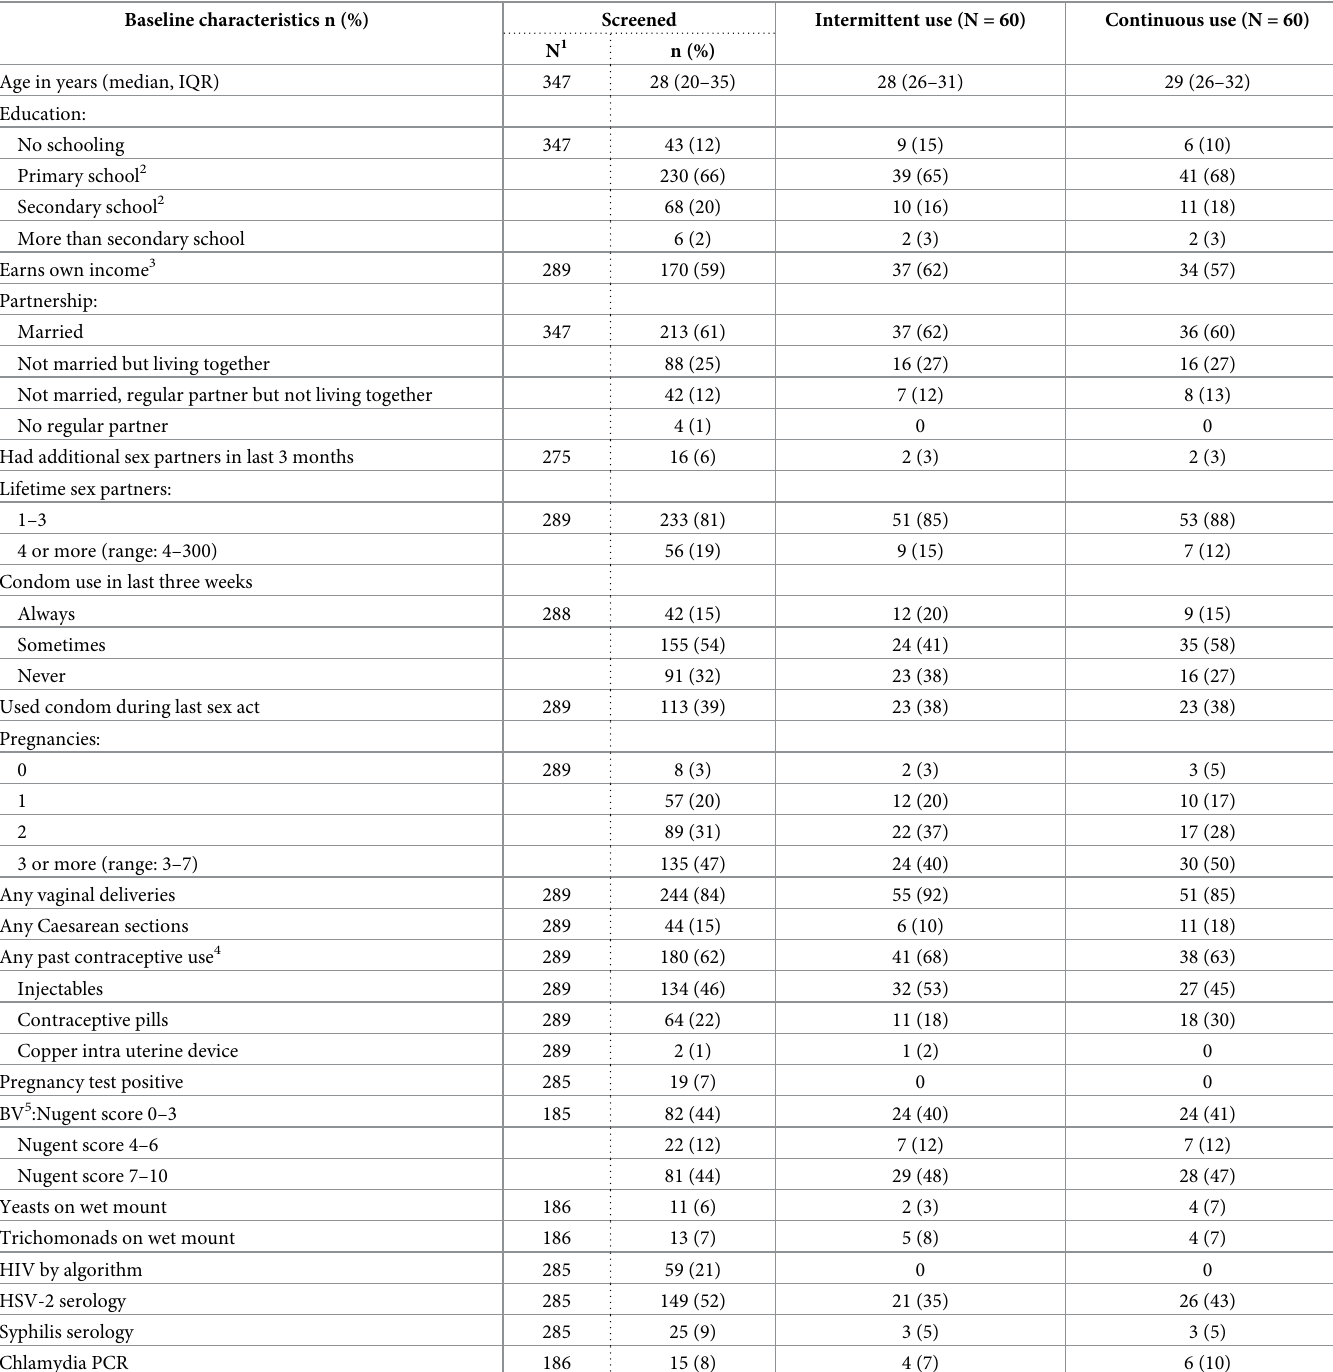
Table 1. Baseline characteristics of the screened population and enrolled population by randomisation group. Baseline characteristics n